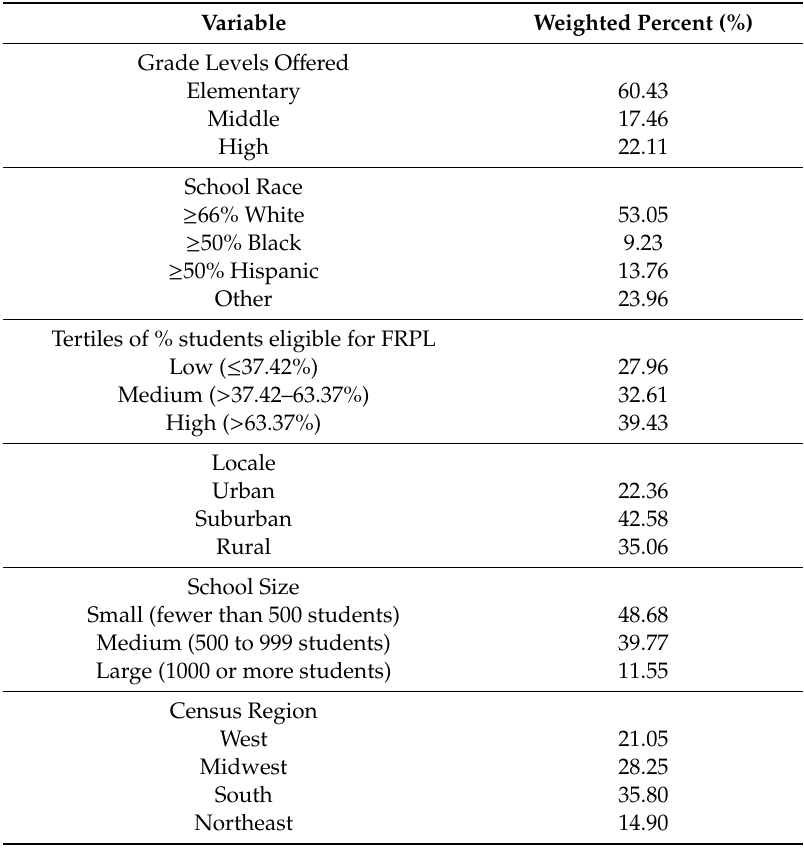
Table 1. Survey-weighted school sample